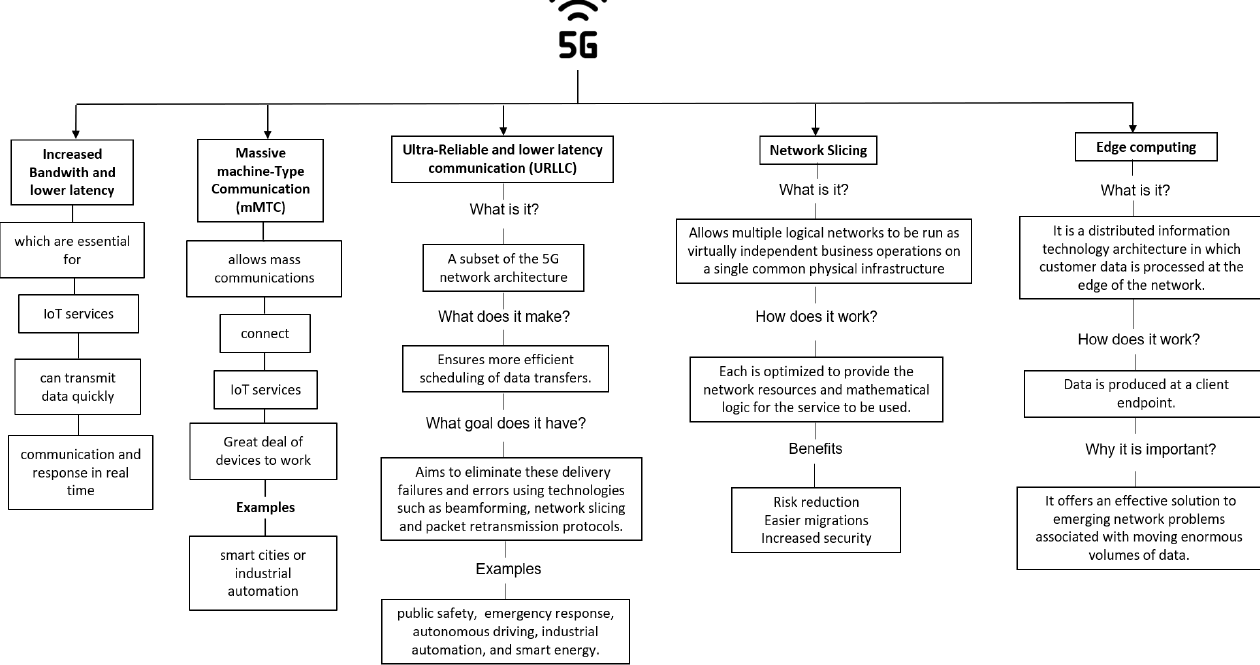
Figure 5. 5G features that are essential for the Internet of Things